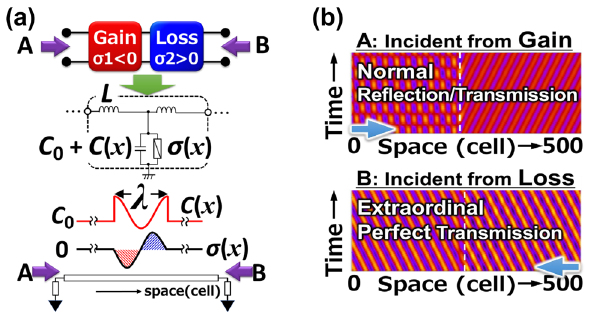
Figure 11: Anisotropic wave propagation in a PT-symmetric system demonstrating the perfect